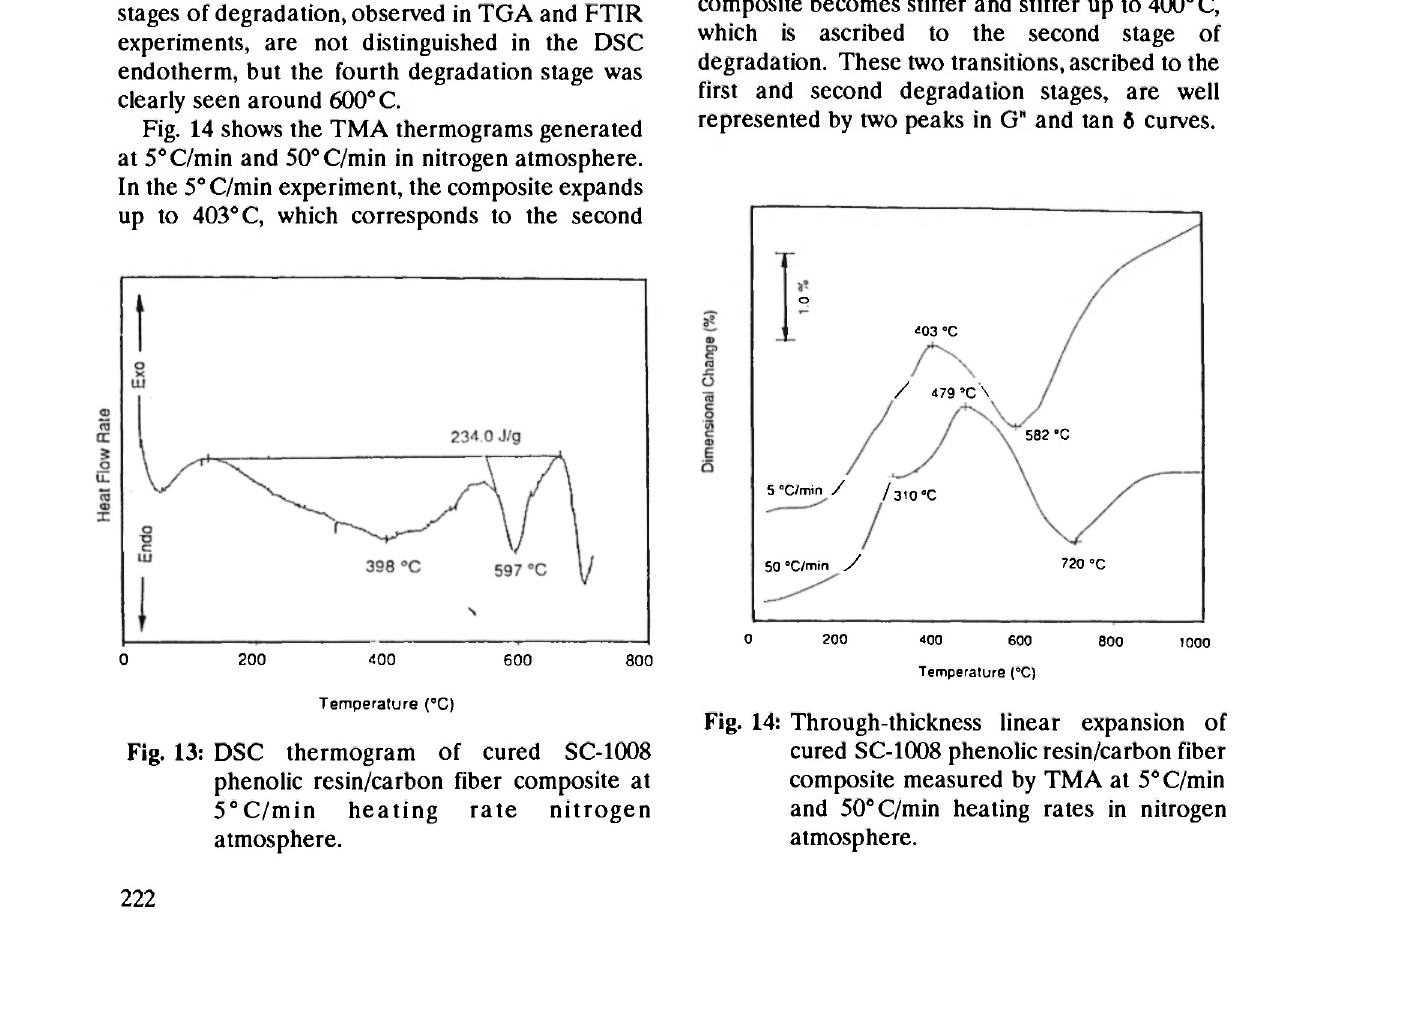
Fig. 12: T GA weight loss and its derivative curves of cured SC-1008 phenolic resin at 5°C/min heating rate in nitrogen atmosphere.